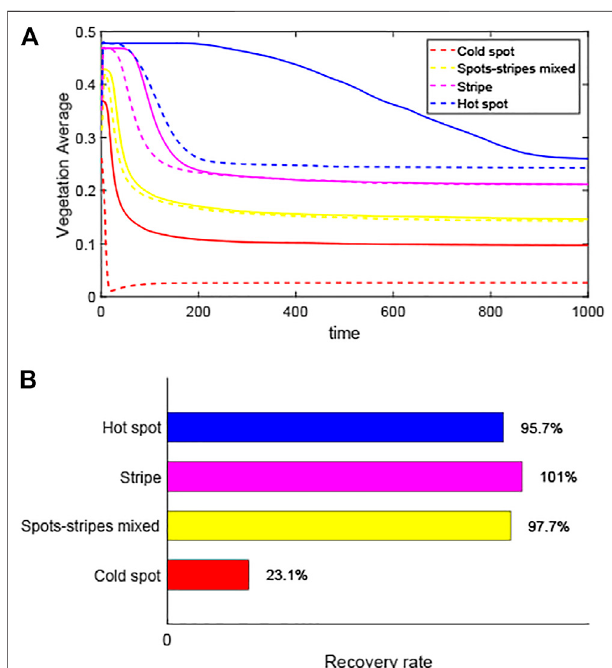
FIGURE 7 | Recovery of different pattern structures for same disturbance. (A) Trajectories of different patterns when they return to steady state after the 20 % disturbance occurs. Solid lines: trajectories of patterns formation; dashed lines: recovery track after the equilibrium point is reduced by 20 % . (B) Recovery rates after a